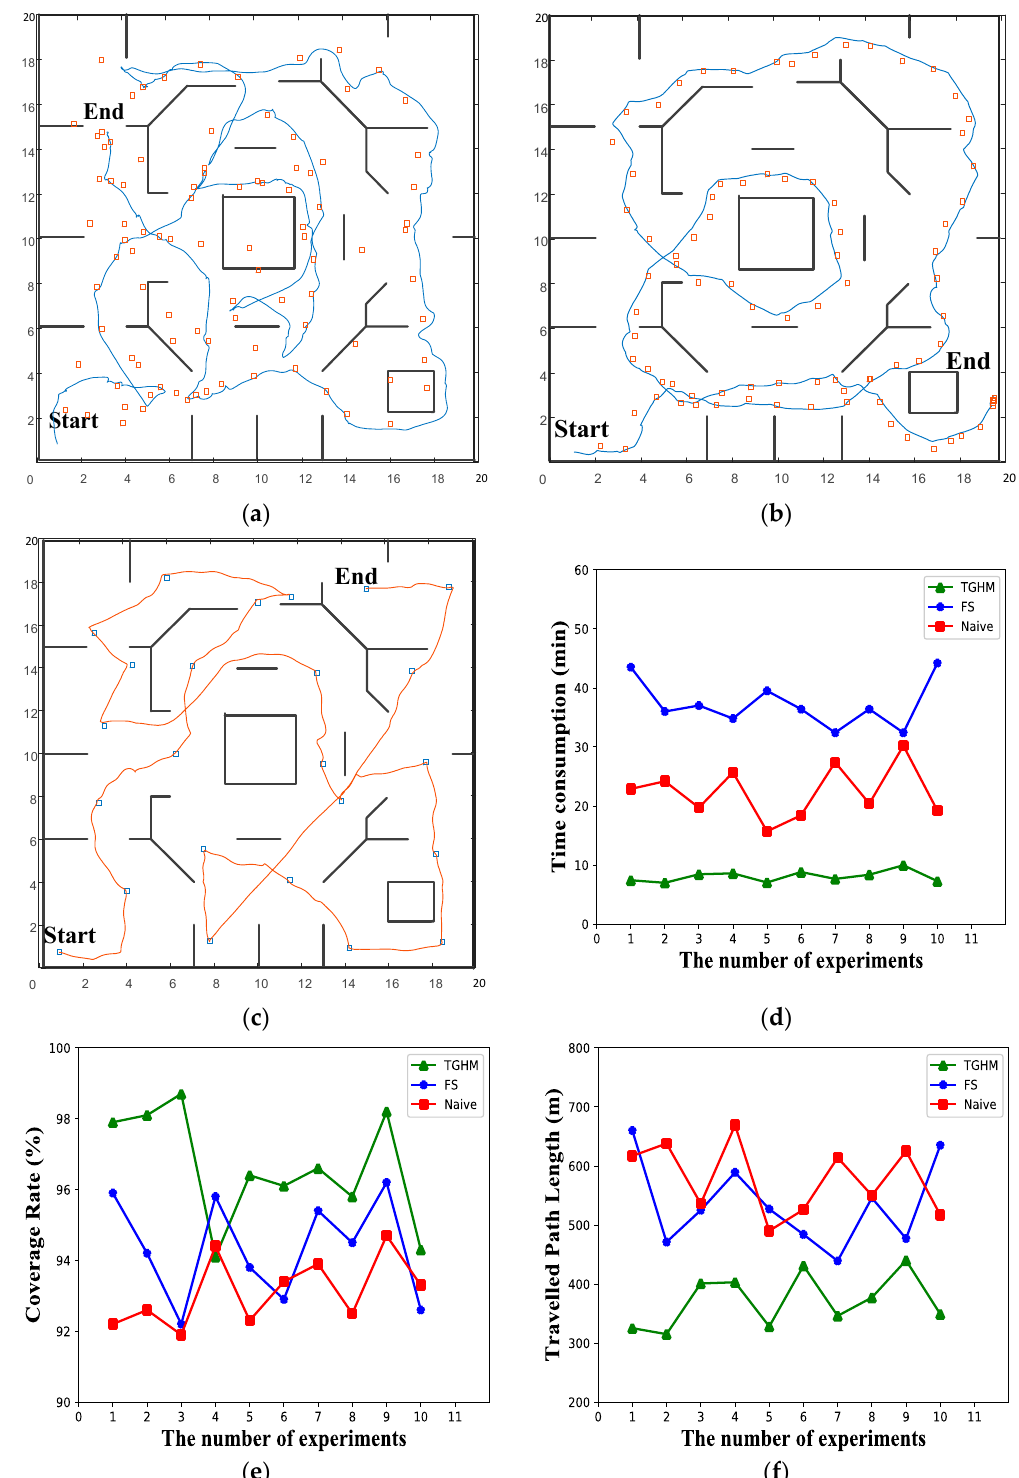
Figure 9. Three types of algorithm for comparison experiment: ( a ) naïve algorithm; ( b ) forward simulation (FS) algorithm; ( c ) TGHM algorithm (ours); ( d ) line chart of exploration time consumption; ( e ) line chart of the coverage rate of the established map; ( f ) line chart of the traveled path length. The simulated robot can turn on the spot and is controlled by applying linear and angular velocity. The maximum linear velocity is 1 m/s, and the maximum angular velocity is 1 rad/s. The robot was equipped with a laser range finder with a maximum range of 5.0 m and a scan range from − 135° to 135°.